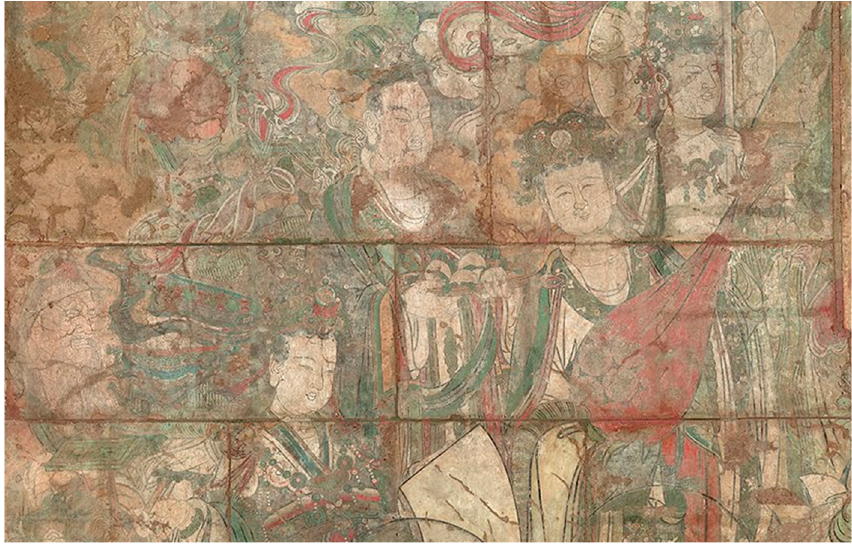
Figure 12. Upper left corner of The Assembly of Tejaprabh ā (detail).